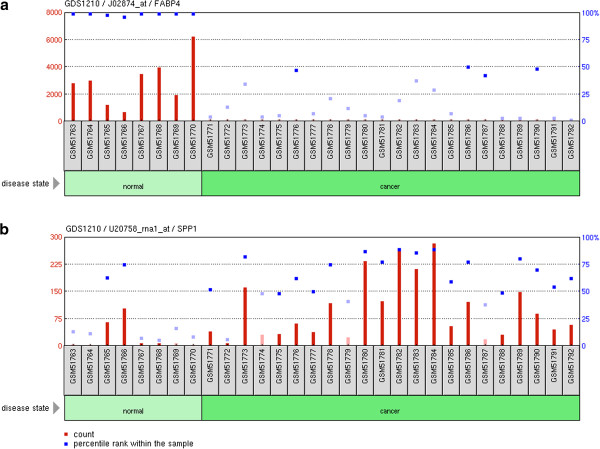
Gene expression levels of FABP4 (a) and SPP1 (b) in each sample. (a)FABP4 is downregulated in gastric cancer (GC) tissue. (b)SPP1 is upregulated in GC tissue.